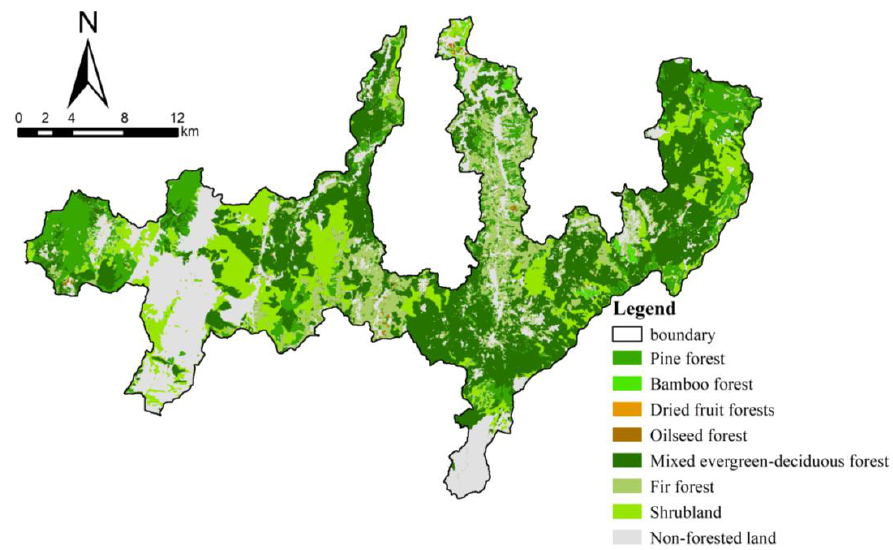
Figure 3. Distribution of forest resources in Hunan Nanshan National Park in 2016.